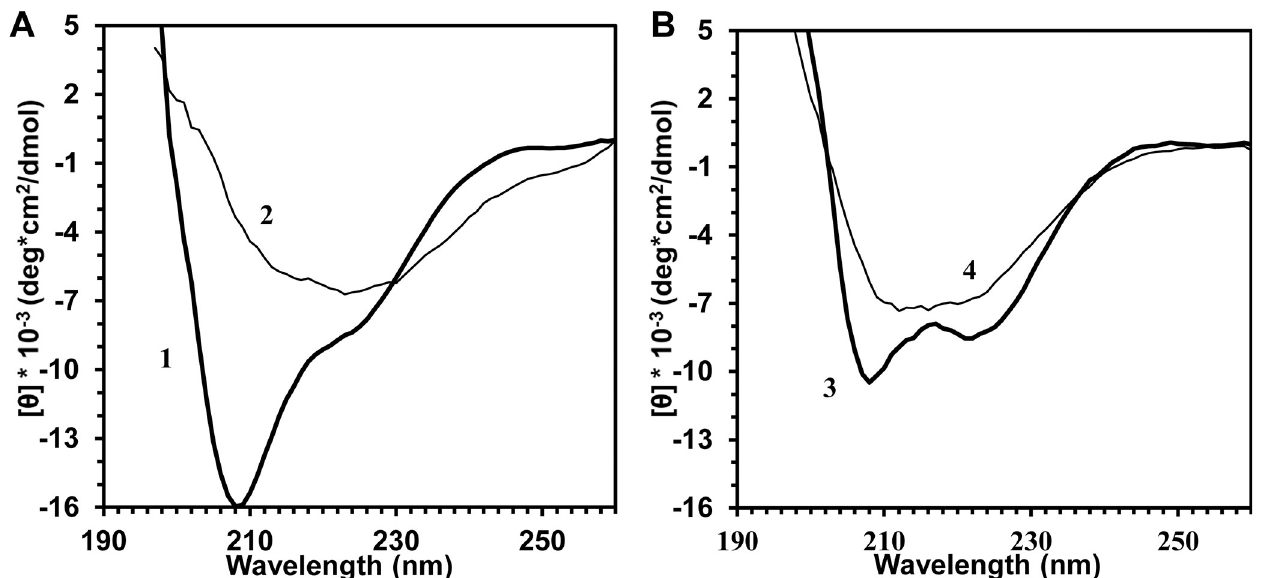
Fig 4. Far-UV CD spectra of A) AltMV virions (1) and SP V (2); B) AltMV VLPs (3) and SP VLP (4). The initial virus and VLPs concentration was 1 mg/ml. The spectra were recorded at 25˚C. The solution details are specified in Materials and Methods. Two repeated experiments were carried out with similar results. The spectra presented in the figure are the visualization of one repetition.